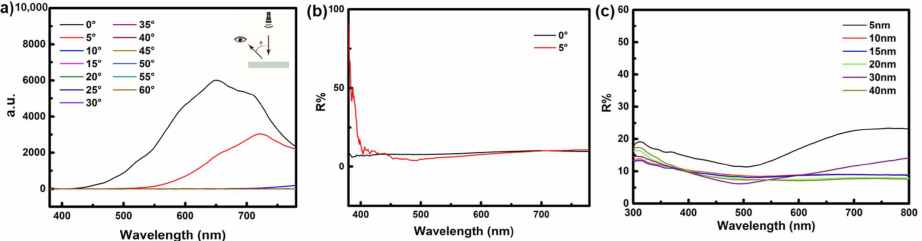
Figure 7. ( a ) Optical backscattering, ( b ) specular reflectance and ( c ) total reflectance spectra of the f 43% samples measured at different angles with fixed angle of